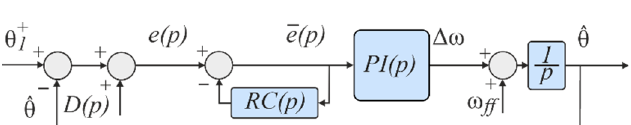
Figure 4. Small signal model of SRF-PLL with the initially proposed modification.